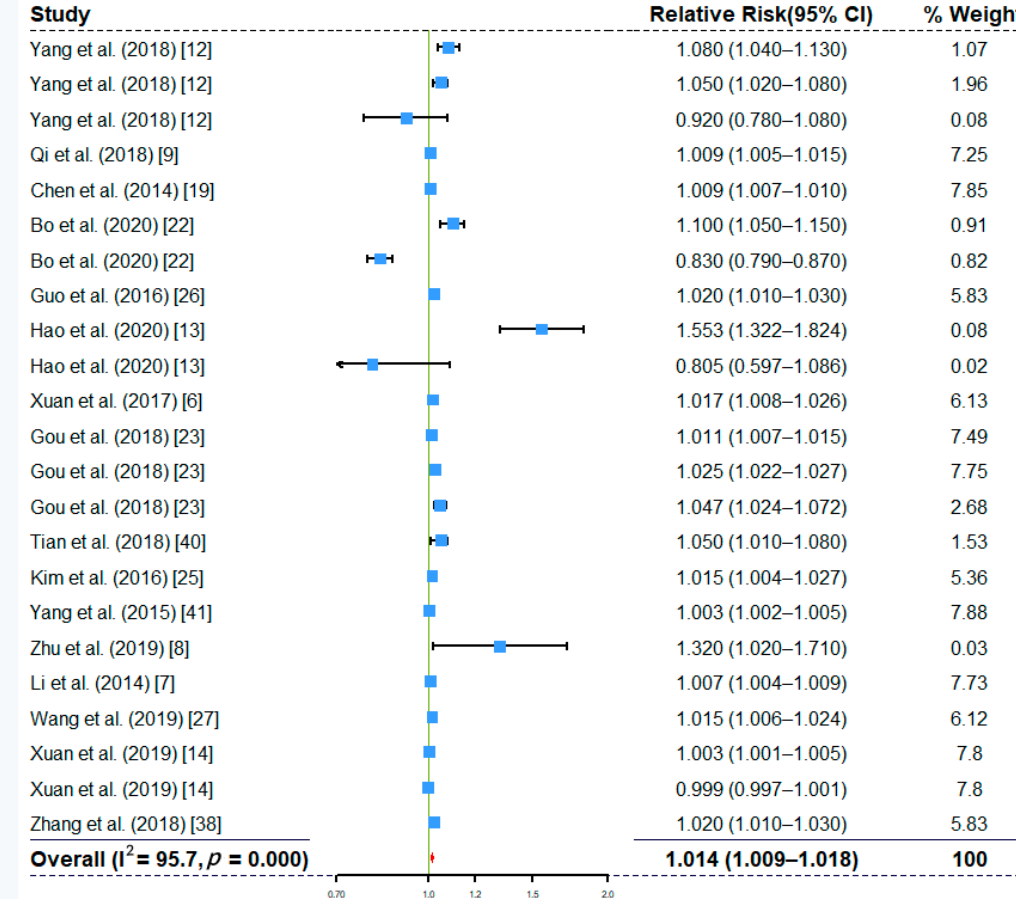
Figure 3. Forest plot showing the effect of relative humidity on the risk of HFMD based on single-day lag models ( n = 23).